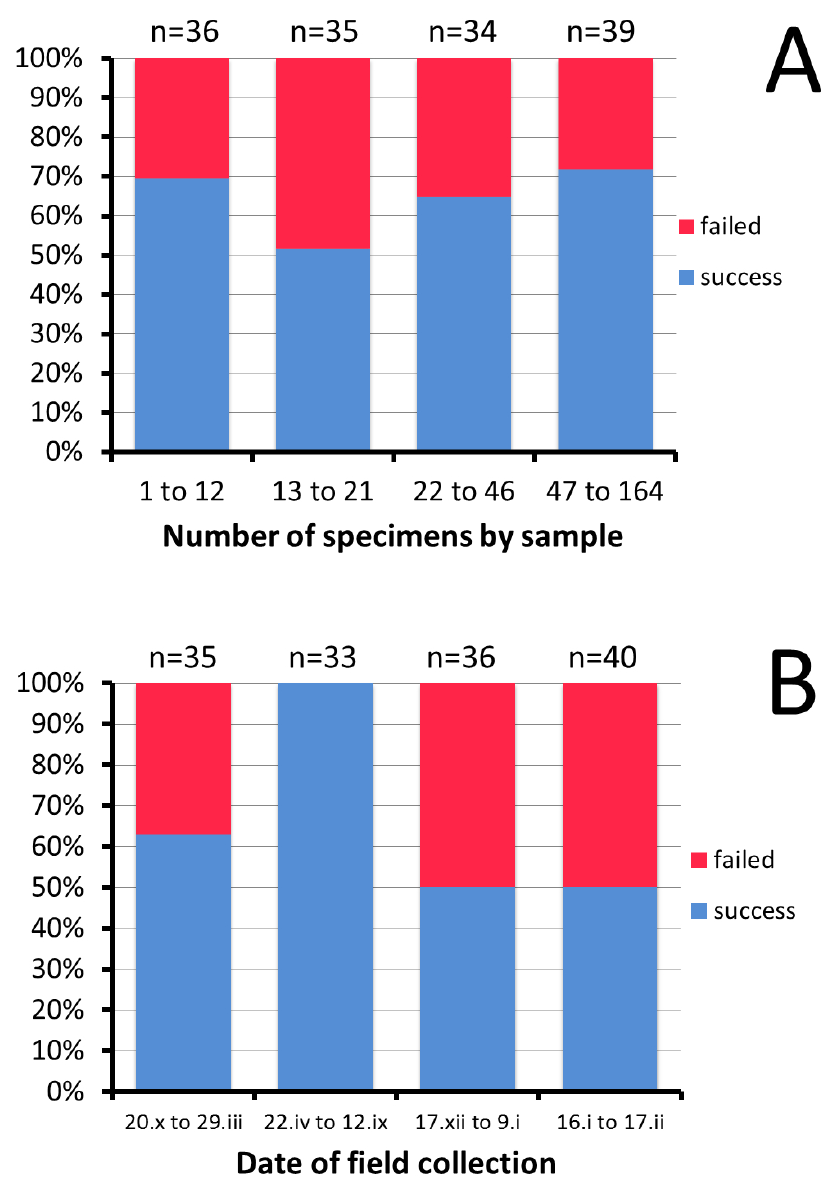
Fig. 1. Percent success and failure in obtaining a COI sequence from specimens. A . Total number of flies in the sample. B . Date of field collection (month indicated in lowercase Roman numerals). n = number of specimens